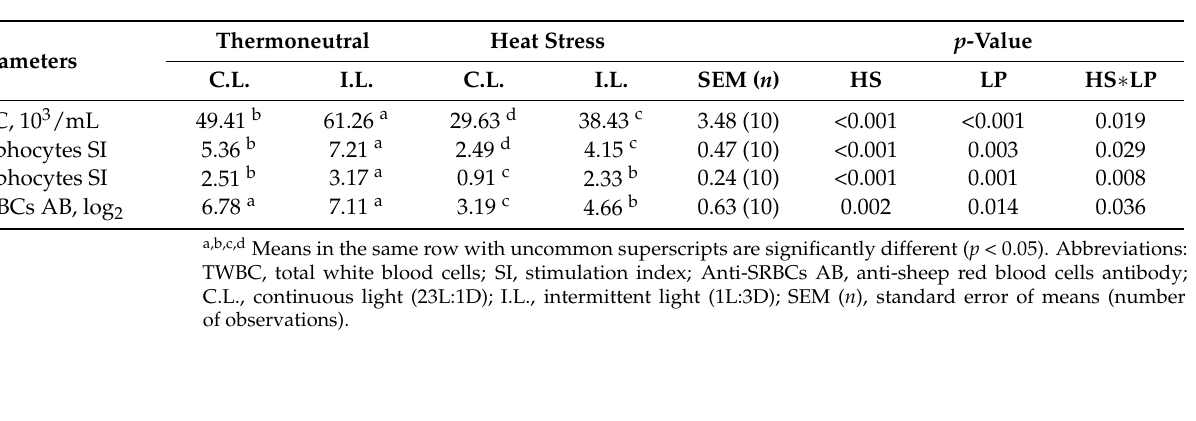
Table 5. Effect of heat stress (HS), light program (LP), and their interaction (HS ∗ LP) on immune response of broiler